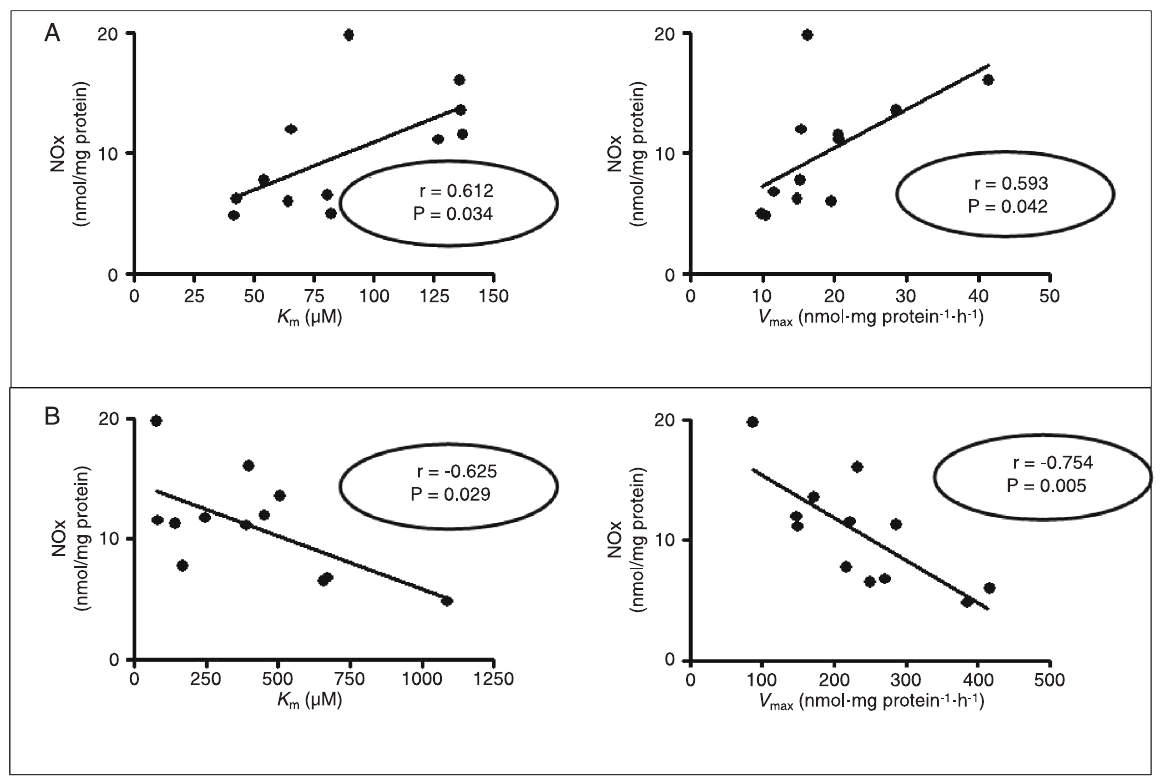
Figure 1. Scatter diagrams showing the correlation between NOx concentrations (y-axis) and K m or V max (x-axis) of MAO-B (A) and SSAO (B) in mesenteric arteries of the control group (N = 12) determined by the Pearson method. NOx = total nitrite/nitrate concentra- tions; MAO-B = monoamine oxidase type B: SSAO = semicarbazide-sensitive amine oxidase.